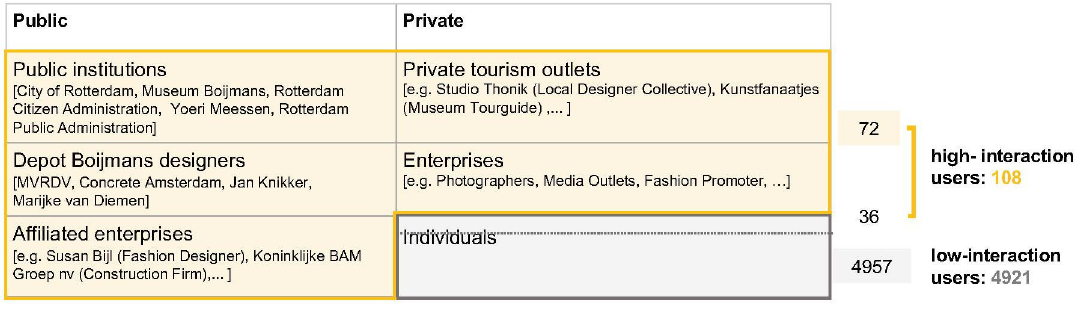
Fig 4. Actors posting on the Depot on